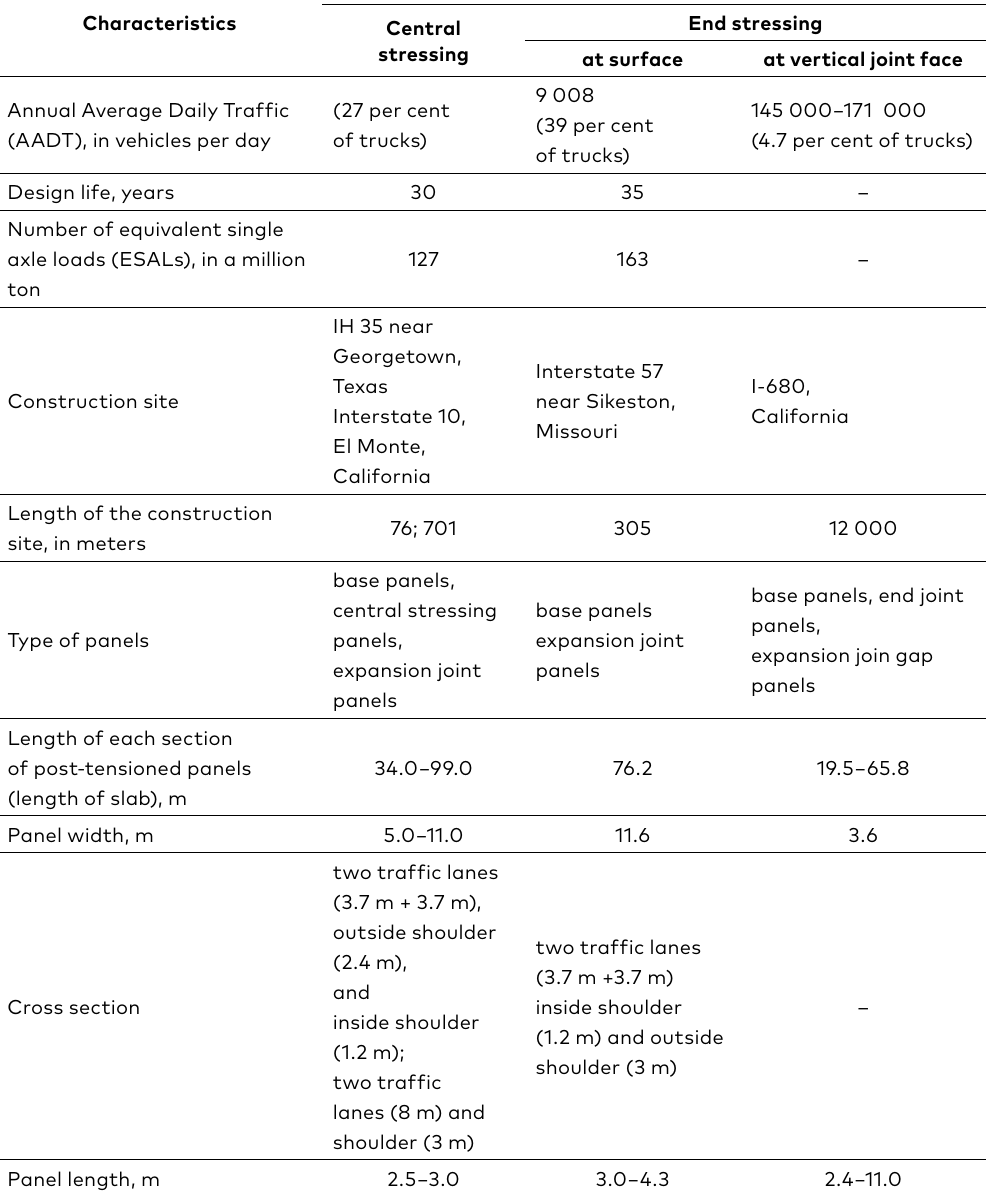
Table 1. Characteristics of Precast prestressed concrete pavement types